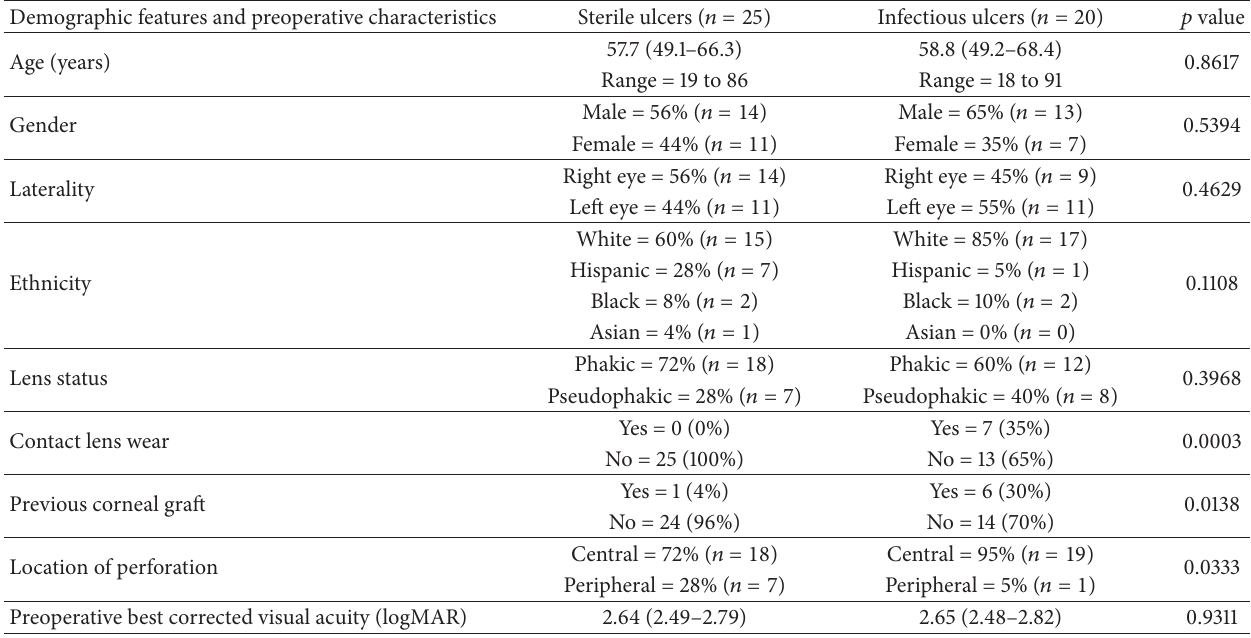
Table 2: Comparison of baseline demographic features and preoperative characteristics of sterile and infectious perforated corneal ulcers that required therapeutic penetrating keratoplasty (with 95% confidence intervals).